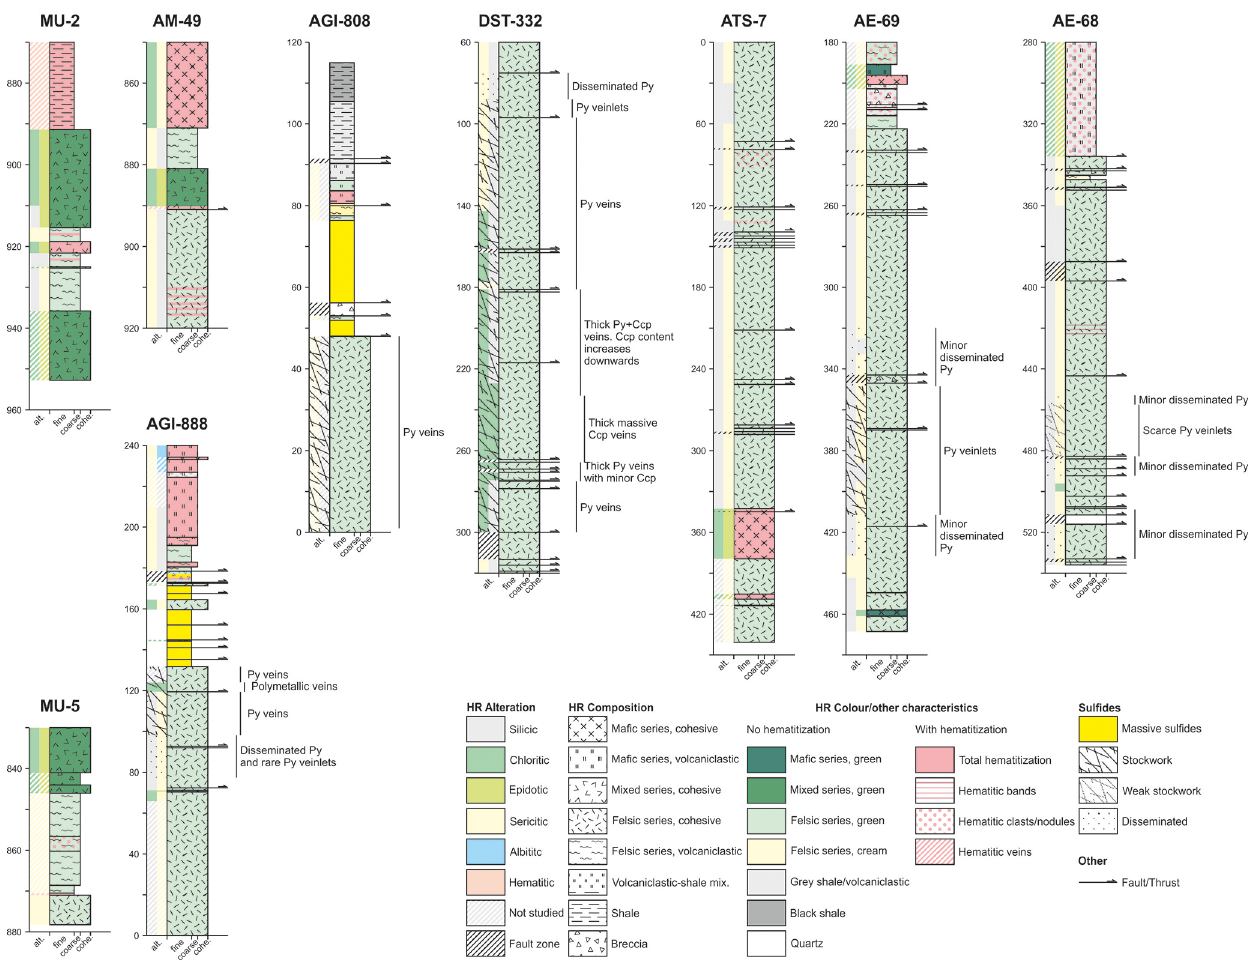
Figure 6. Schematic stratigraphic columns of the main studied drill cores. The depth along the core is in metres